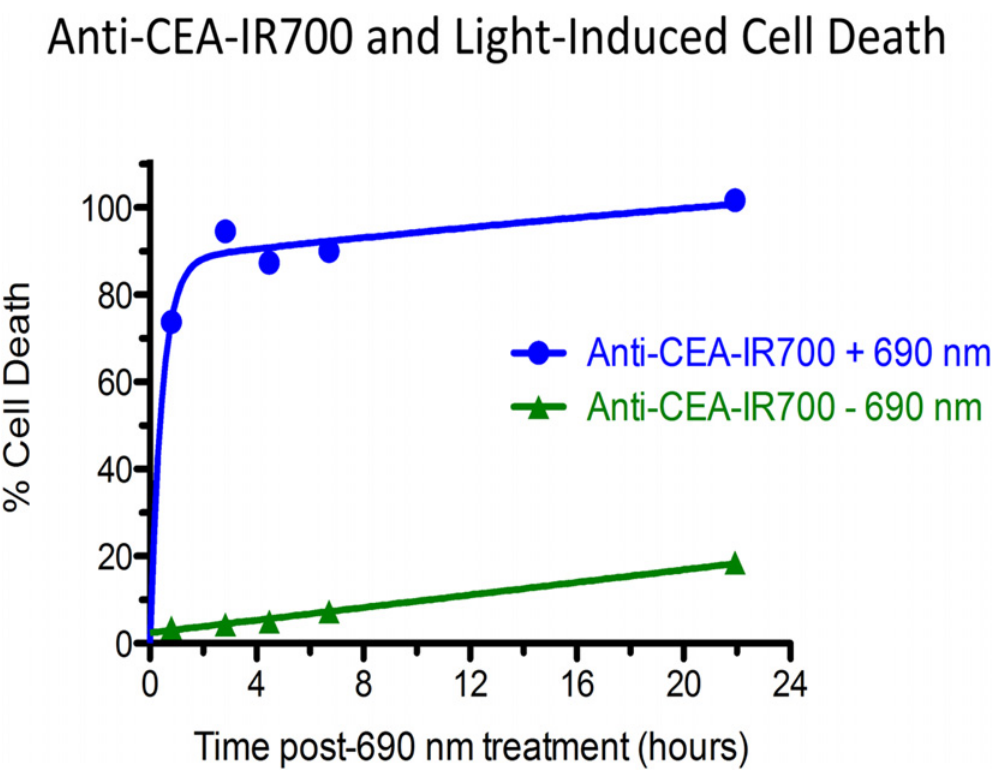
Fig 2. Light-induced cell death by cell-bound anti-CEA-IR700. BxPC-3 cells were incubated with anti-CEA-IR700 conjugate (10 μ g/ml). Rapid cell killing was observed with a dose of 32 J/cm 2 of 690 nm near-infrared light (blue circles), whereas only little cell killing occurred without illumination (green triangles). Death in light-treated cells in the absence of anti-CEA-IR700 was negligible (data not